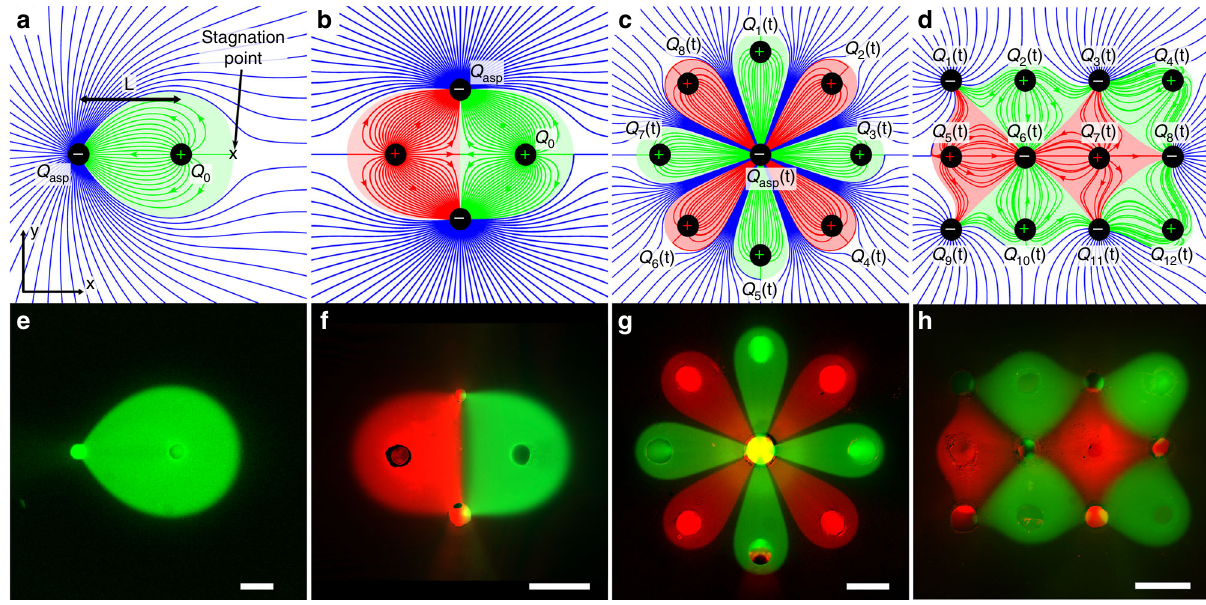
Fig. 1 From dipoles and quadrupoles to multipoles. Theoretical streamlines ( a – d ) and fl uorescence micrograph ( e – h ). Positive and negative sign, respectively, represent injection and aspiration apertures. To facilitate comparison between theory and experiment, green and red background were superposed on fl ow fi elds to highlight the expected areas of con fi nement not captured by streamlines. a , e Micro fl uidic dipole. b , f Micro fl uidic quadrupole. c , g MFM with rotational symmetry. d , h 12-aperture MFM with translational symmetry. Scale bars represent 500 μ